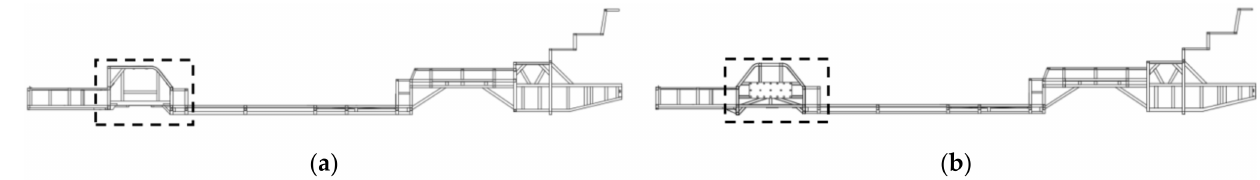
Figure 16. ( a ) Bus chassis without a replaced front suspension frame module; ( b ) Bus chassis with a replaced front suspension frame